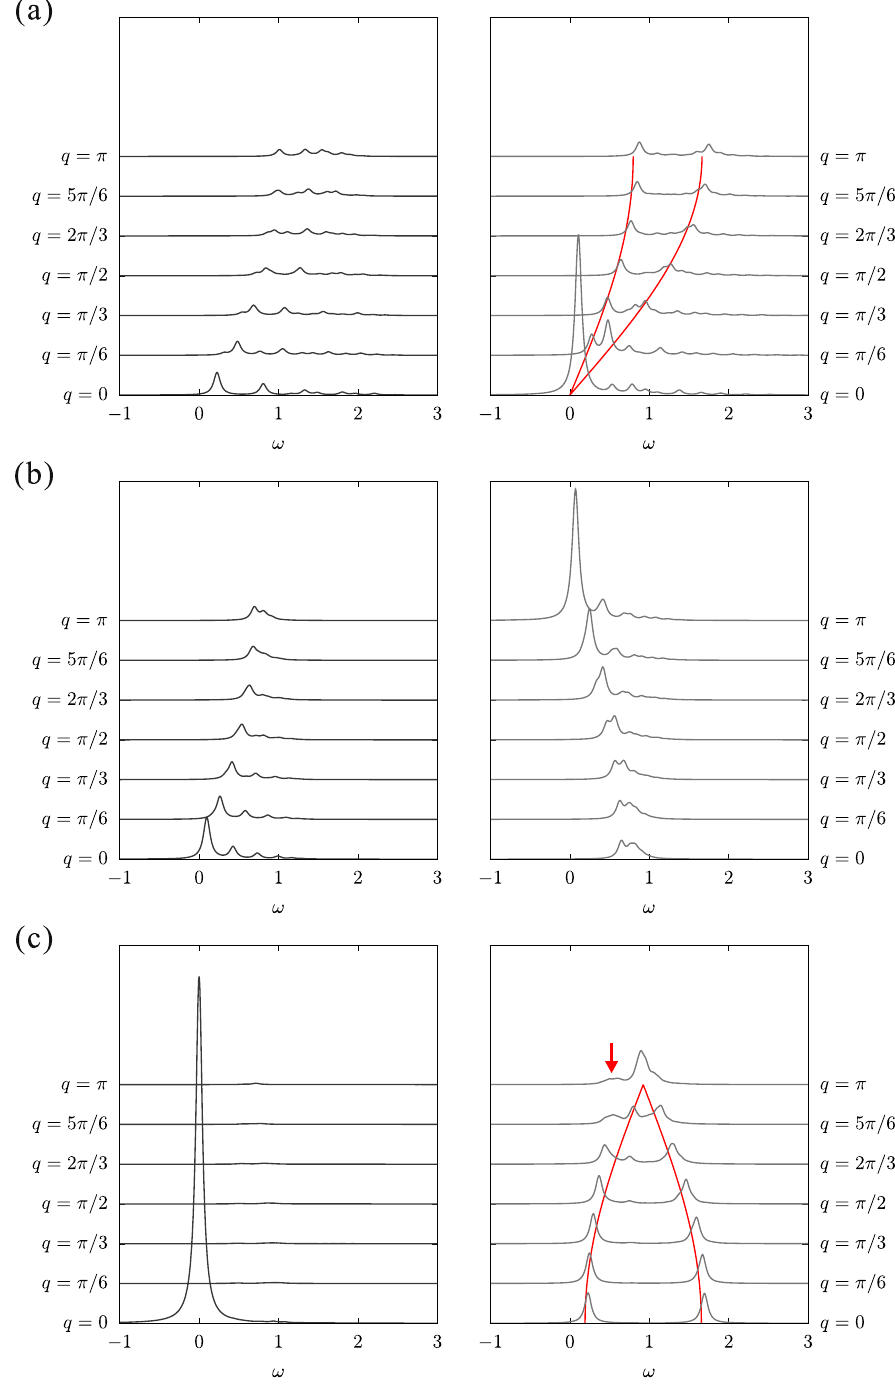
Figure 10. Dynamical structure factors calculated with a periodic 24-site chain for ( a ) TLL φ   =   π , ( b ) spiral- 3 xy [ φ = π 5 ], and ( c ) FM- z [ φ = π 7 ] states. The left and right panels show S z ( q , ω ) and S − ( q , ω ), respectively. The 8 8 red lines are analytical dispersions: Eq. (38) for φ = π and Eq. (41) for φ = π 7 . The arrow indicates an 3 8 appearance of the spiral- xy fluctuation in the FM- z